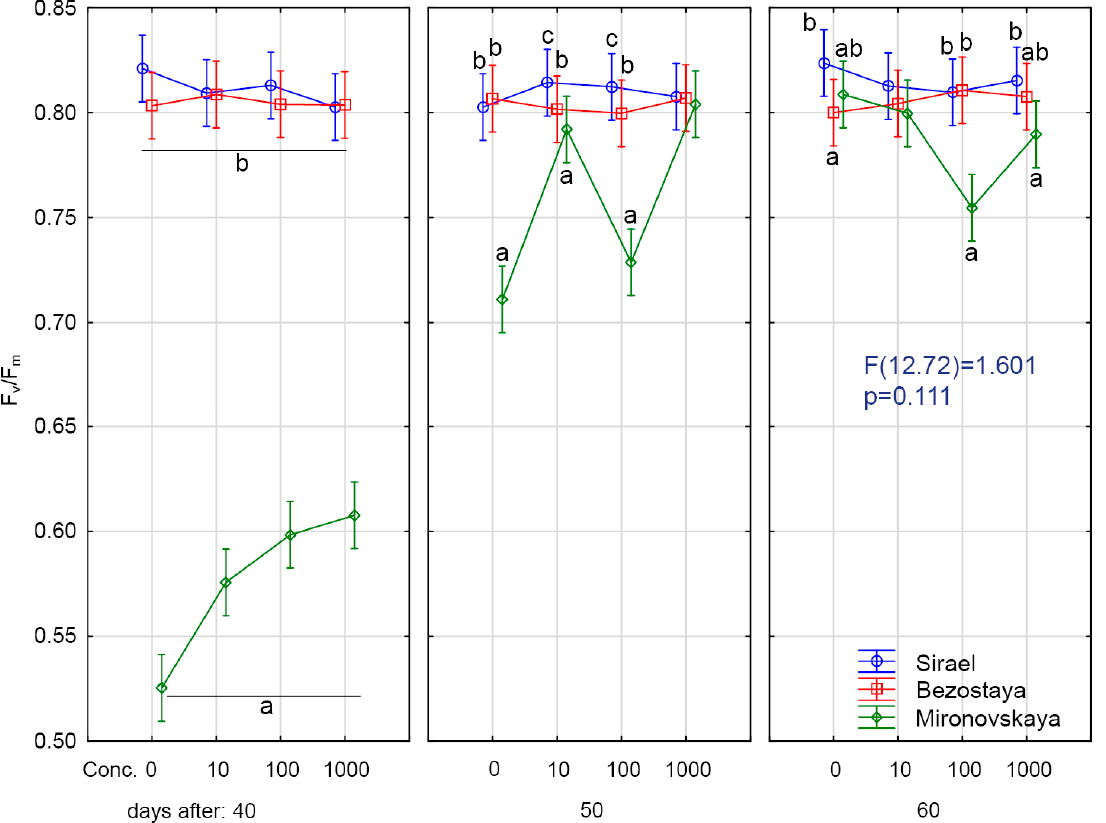
Figure 1. Optimal quantum yield (F v / F m ) after GA 3 treatment. Variety: Mironovskaya (M), Bezostaya (B) and Sirael (S). Concentrations of GA 3 : 0, 10, 100 a 1000 µ L L − 1 ; measured on 40 days, 50 days and 60 days of growth. Tukey HSD test, α = 0.05. Treatments with the same sign did not di ff er significantly at p < 0.05.